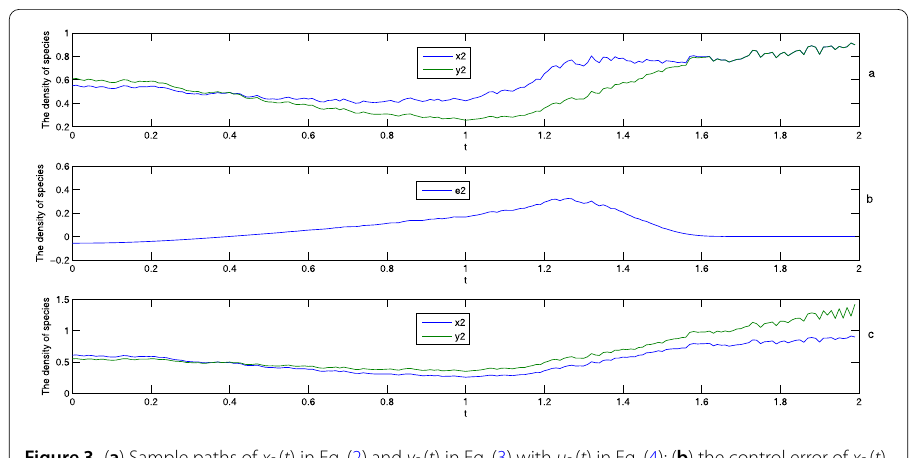
Figure 3 ( a ) Sample paths of x 2 ( t ) in Eq. (2) and y 2 ( t ) in Eq. (3) with u 2 ( t ) in Eq. (4); ( b ) the control error of x 2 ( t ) and y